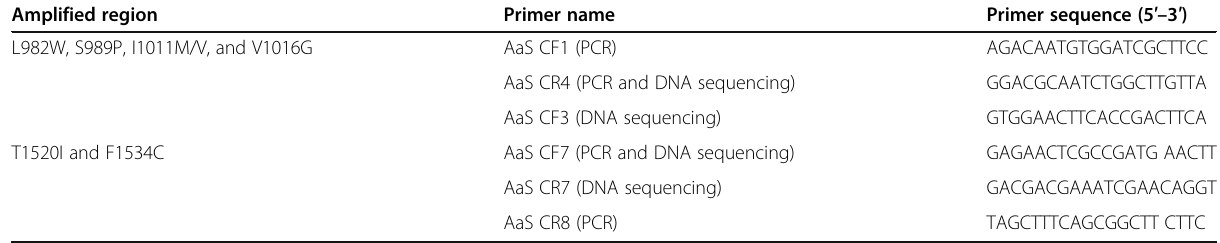
Table 1 The primers used for the kdr genotyping Amplified